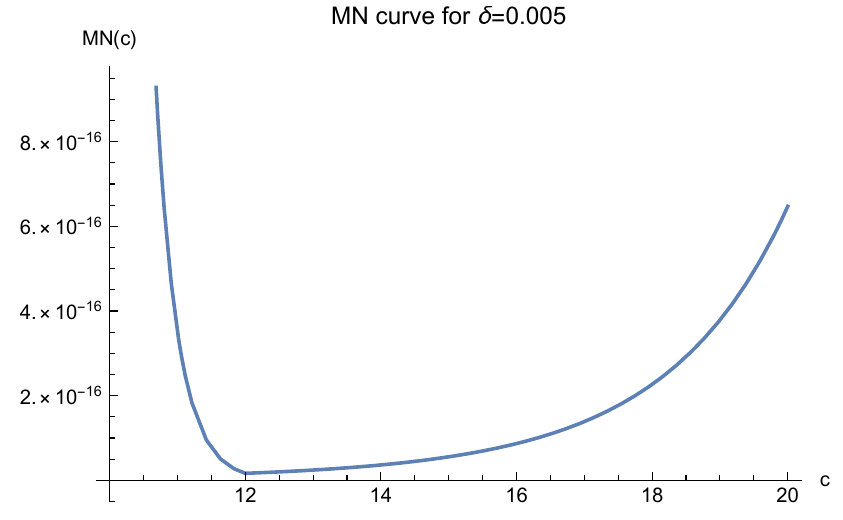
Figure 1. MN curve for δ = 0.005 where d = 1, β = 1, b 0 = 1 and σ = 10 − 1 .